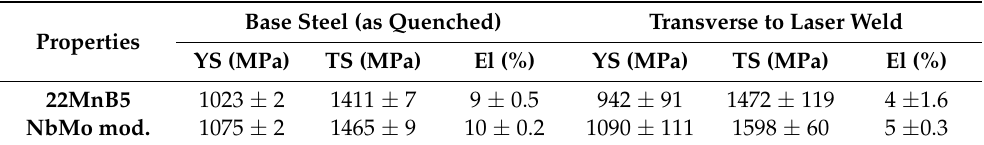
Table 2. Tensile mechanical properties of as-quenched base steels and laser-welded samples trans- verse to weld seam (YS: yield strength, TS: tensile strength, El: total elongation). Properties